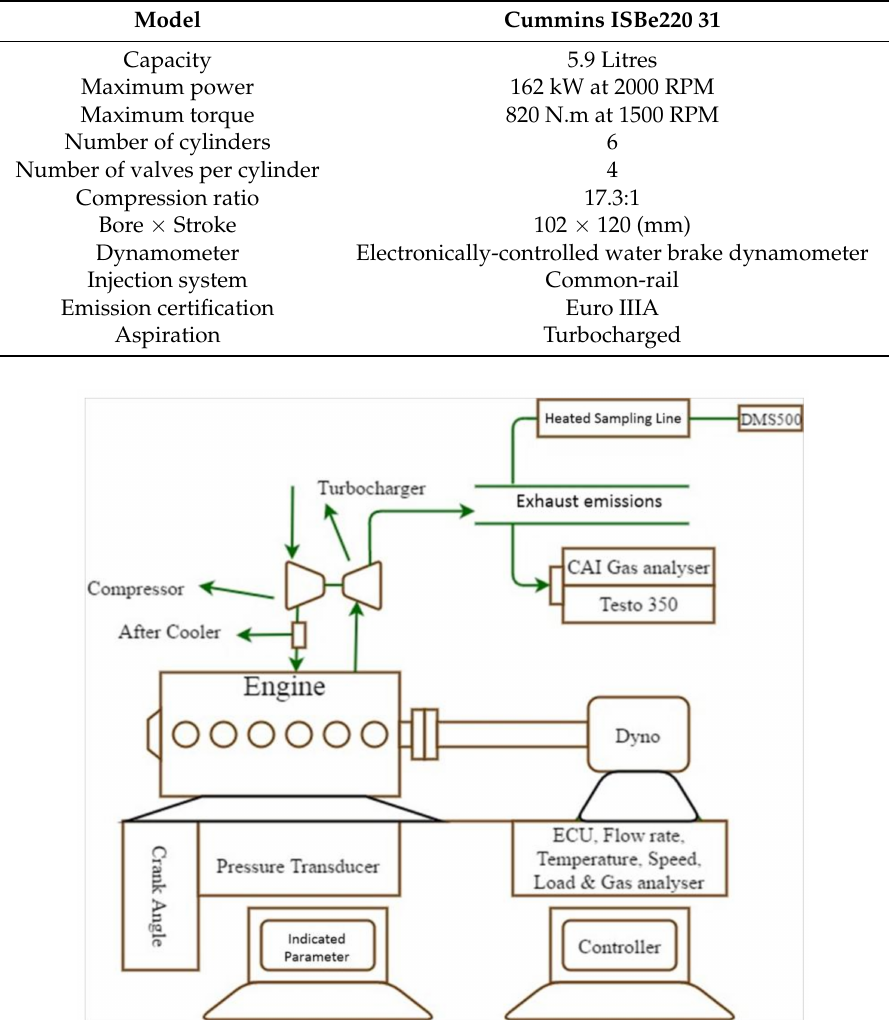
Figure 2. Schematic diagram of engine campaign